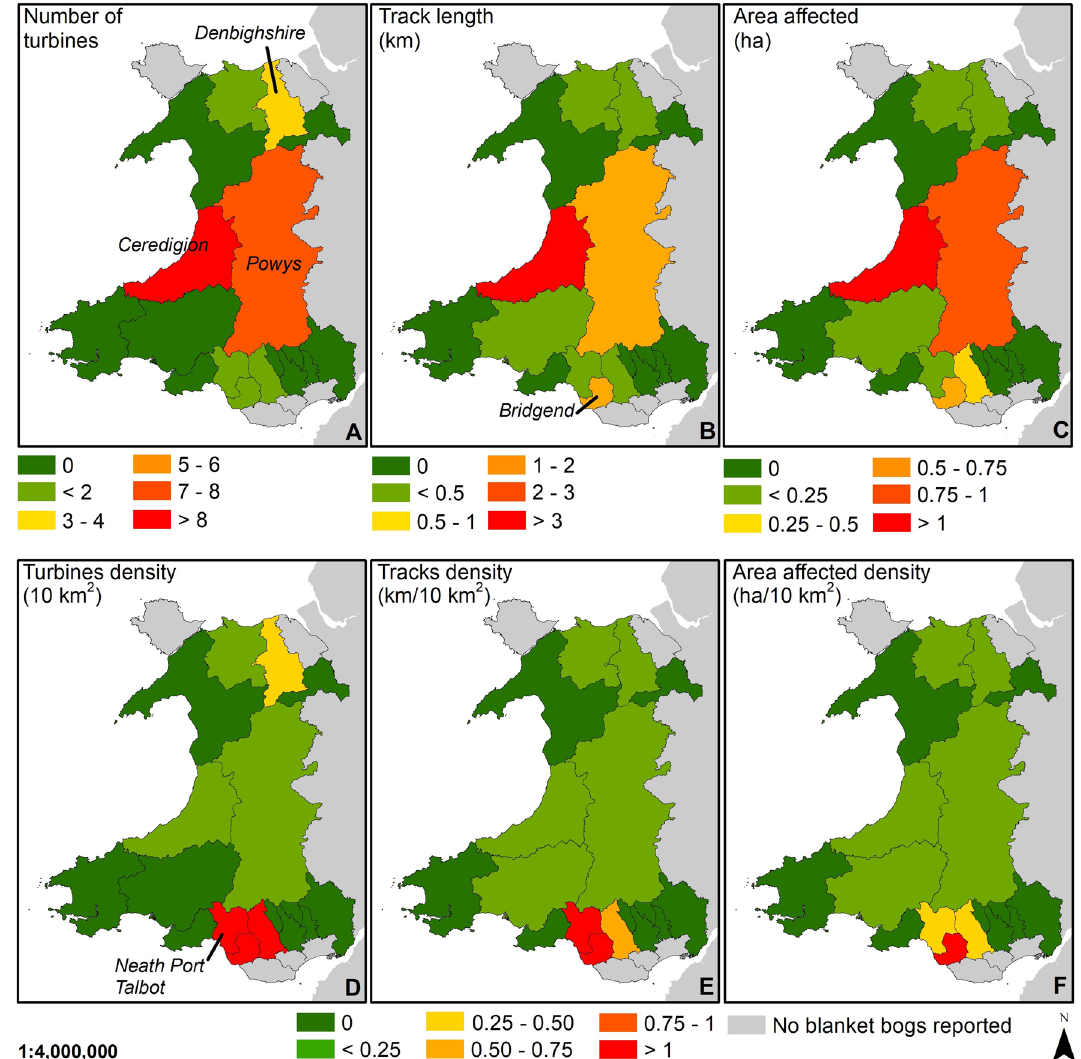
Figure 5. The extent of windfarm developments in Wales by county. ( A ) Total turbines on blanket bog habitat by county. ( B ) Tracks length on blanket bog habitat by county. ( C ) Total area affected by wind farm developments on blanket bog habitat by county. ( D ) Density of turbines by 10 km 2 of blanket bog habitat by county. ( E ) Density of tracks by 10 km 2 of blanket bog by county. ( F ) Density of area affected by wind farm developments by 10 km 2 of blanket bog habitat by county. Datasets for blanket bog habitat 7130 : Wales 35 . Map created in ArcGIS